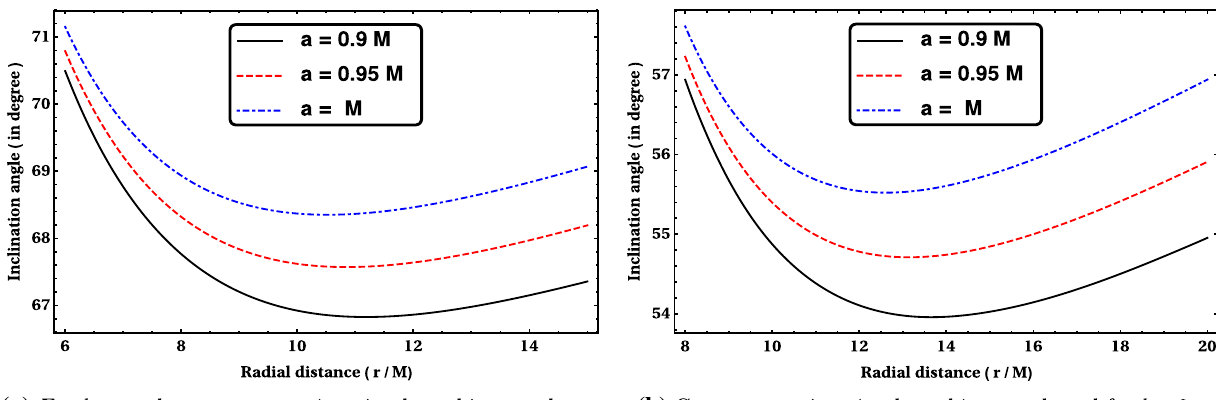
Fig. 4 The counter-rotating circular orbits are shown for Kerr–Newman-NUT blak hole with the horizon located at r = 2